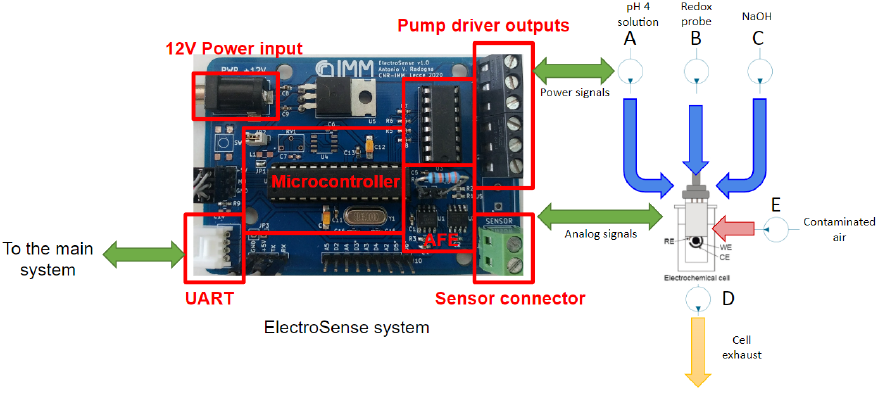
Figure 3. Photo of the ElectroSense mainboard ( left ) and picture of the fluidic circuit ( right ). The system includes 3 main